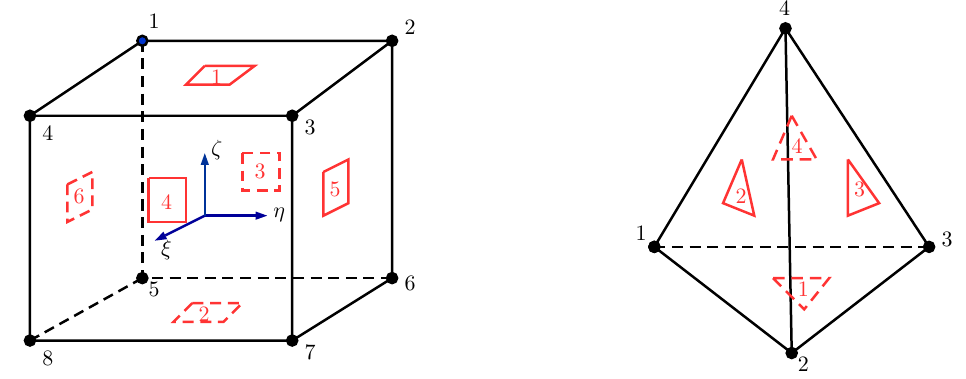
Figure 1. Schematic of hexahedral (LSPiezo) and tetrahedral (LTRPiezo) reference element for piezo-elastic coupling implemented in